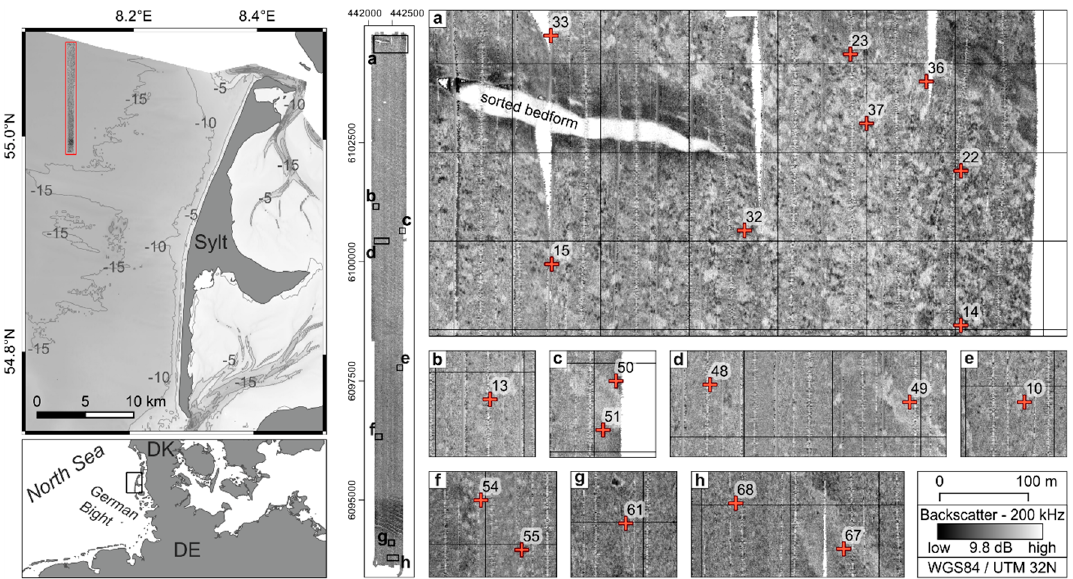
Figure 1. Left hand side: Overview and bathymetry map o ff shore Sylt. Middle: A ship-based backscatter intensity map of the investigation area. Right hand side: Close up of the study area and the lander deployment stations (red cross), with Norbit multibeam echosounder backscatter data recorded at a frequency of 200 kHz. The dynamic range of the shown uncalibrated backscatter values is approx. 10